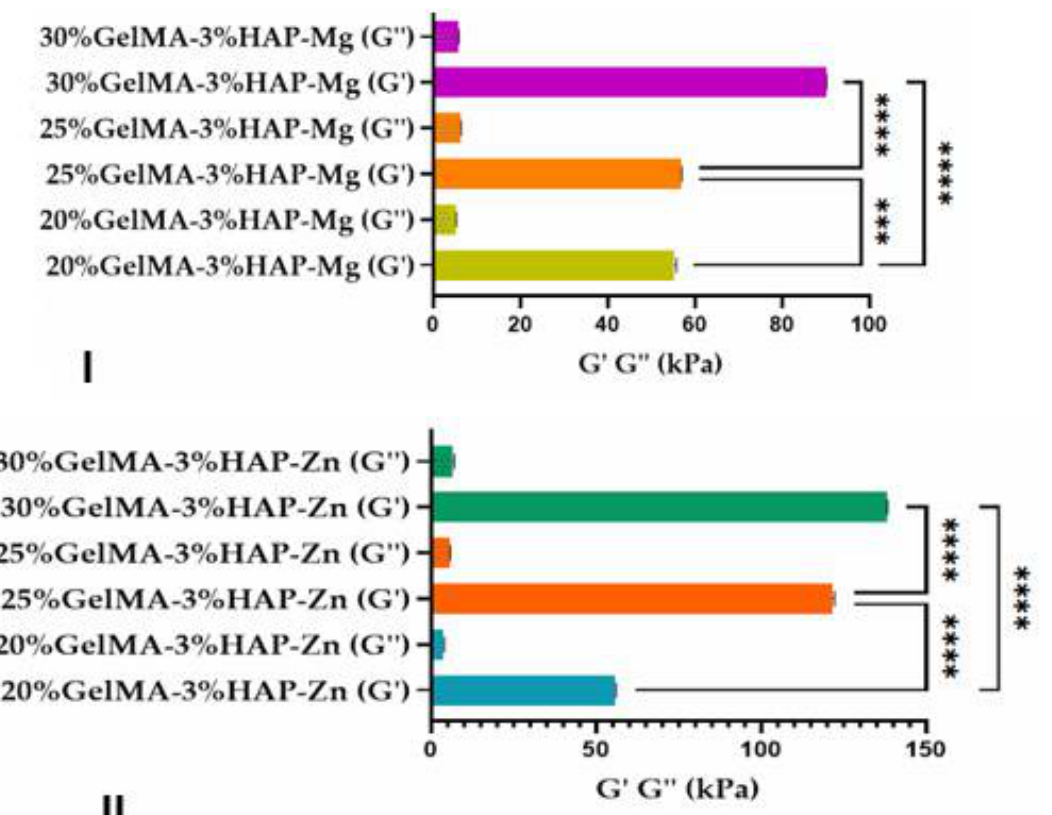
Figure 12. Storage and loss moduli of the GelMA-inorganic filler ((I)—HA doped with magnesium ions and (II)—HA doped with zinc ions) determined by the nanoindentation technique. Statistical significance: **** p < 0.0001.